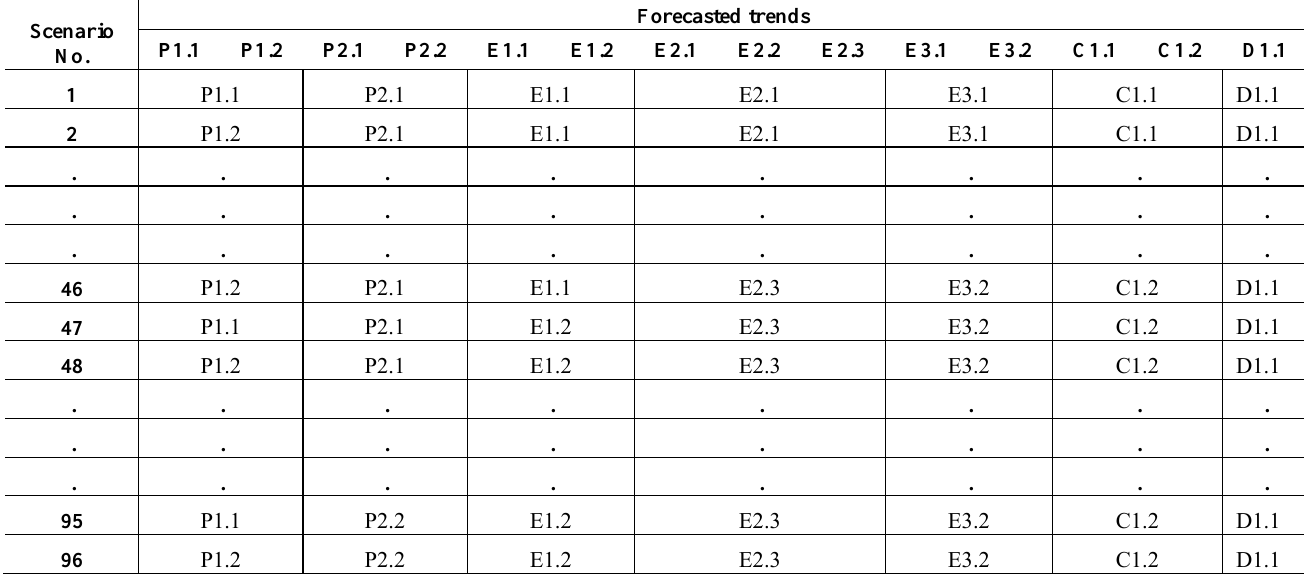
Table 3: The pairwise FCIs between forecasted future trends